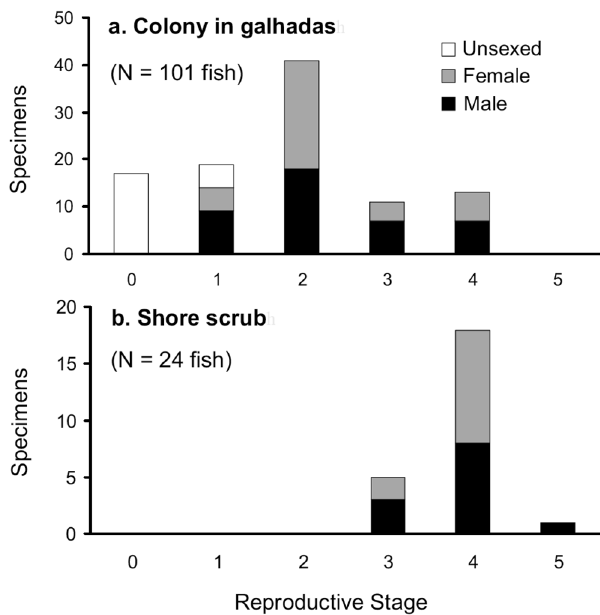
Fig. 11. Reproductive status and sex of putative (a) 1+ and (b) 2+ cohort members Symphysodon haraldi from a single large discus colony in Uxi Bay, lago Amanã, 1998. Only specimens that were dissected for sex determination are included. The single 1+ specimen with a stage 4 gonad is illustrated in Fig.